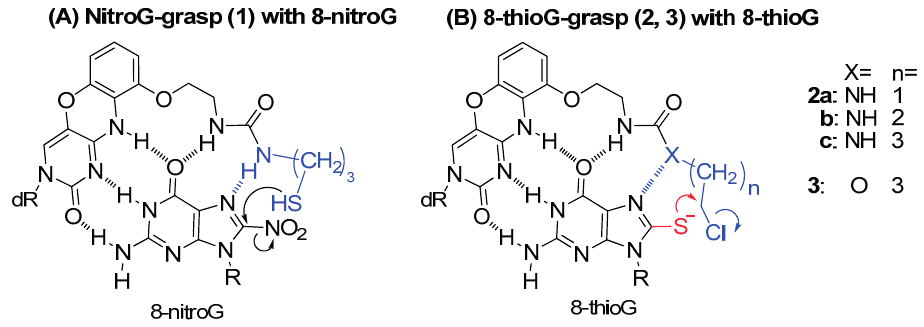
Figure 1. Molecular design of the selective capture molecules for 8-nitroG and 8-thioG. dR and R represent 3 ′ ,5 ′ -diOTBS-2 ′ -deoxyribosyl and triacetyl ribosyl groups,